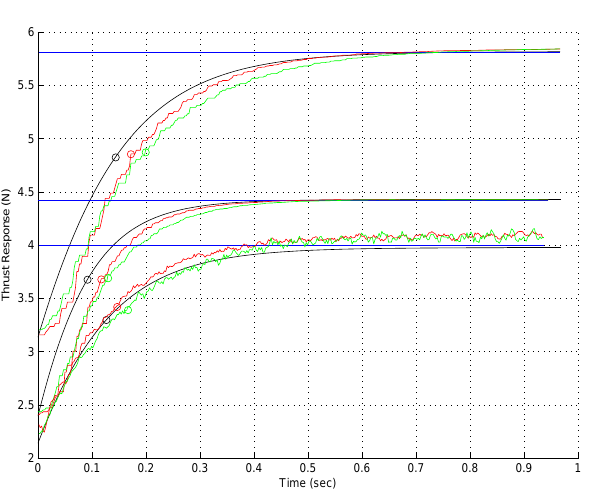
Figure 8: Thrust response per propeller, Test Case I. Top: 4 Actuators, Middle: 6 Actuators, Bot- tom: 8 Actuators. Blue: Input, Red: Accel- eration, Green: Deceleration, Black: Simula- tion model. The circles represent the thrust at the 63% rise time.